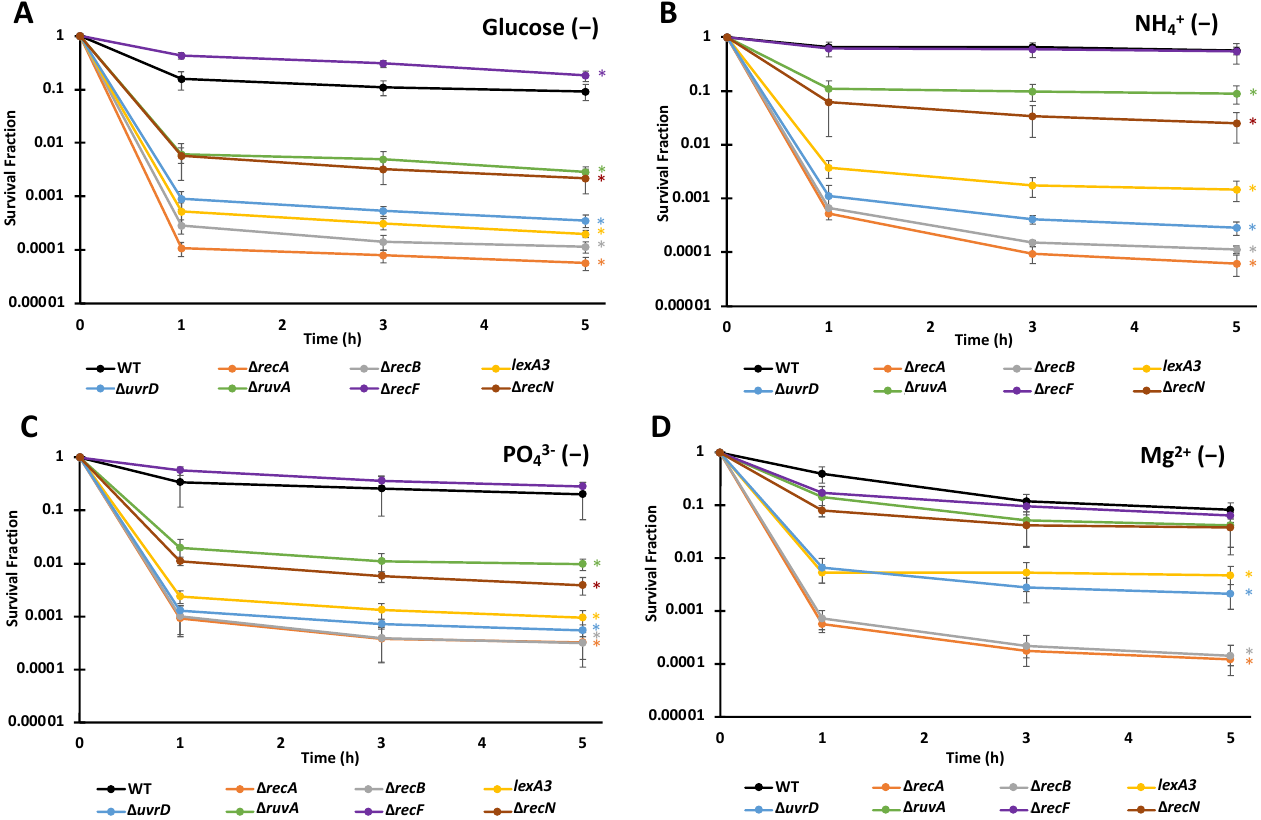
Figure 3. Importance of DNA repair machinery to LEVO persistence is largely invariant in non- growing populations starved for different nutrients. Persister levels in populations of ∆ recA , ∆ recB , lexA3, ∆ uvrD , ∆ ruvA , ∆ recF , ∆ recN and WT under the indicated starvation conditions were assessed with LEVO. Data points indicate the means of three biological replicates, whereas the error bars indicate the standard errors of those means. One-way ANOVA with post-hoc Tukey test were conducted for each starvation condition to assess significance. ( A ) Under C-starvation ∆ recF exhibited significantly higher survival compared to WT at 1, 3, and 5 h. All other strains had significantly lower survival rates than WT at these time points. ( B , C ) Under N and P starvation all strains except ∆ recF exhibited lower survival rates when compared to WT at 1, 3 and 5 h time points. ( D ) ∆ recA , ∆ recB , lexA3, ∆ uvrD strains had a significantly lower survival rate compared to WT under Mg 2+ - starvation at 1, 3 and 5 h. Significance was identified as p < 0.05.